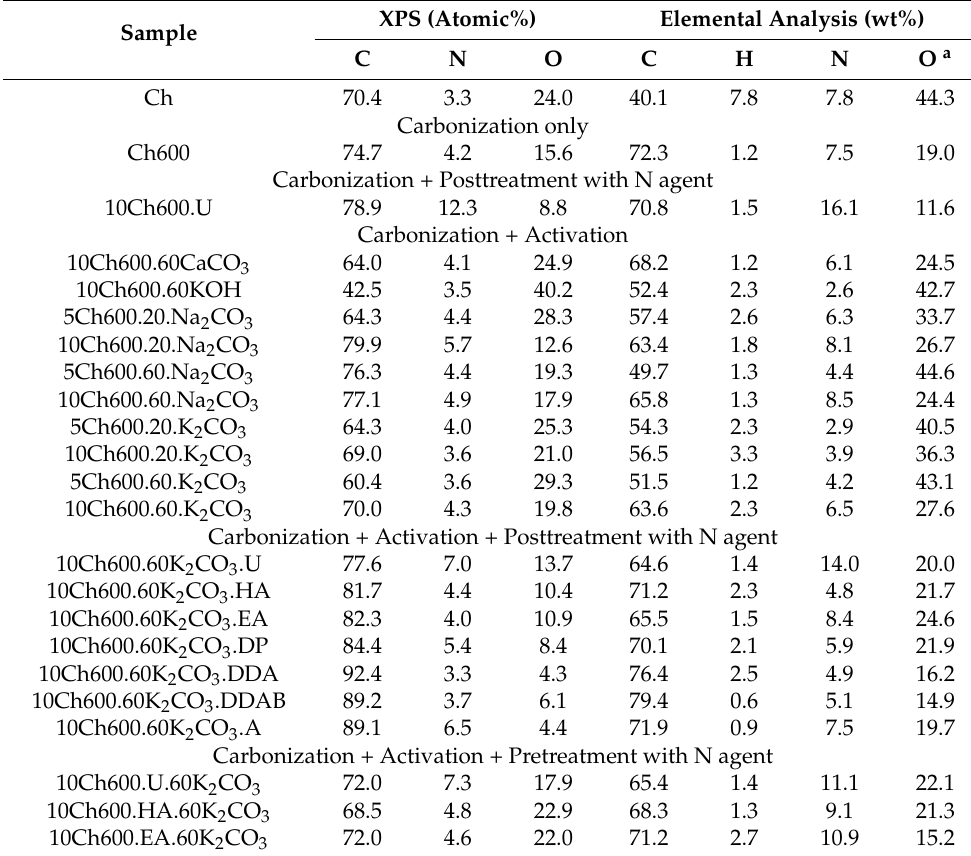
Table 2. Surface (XPS) and bulk (CHN) elemental composition of chitosan-based AC with different activators and a different functional group for N